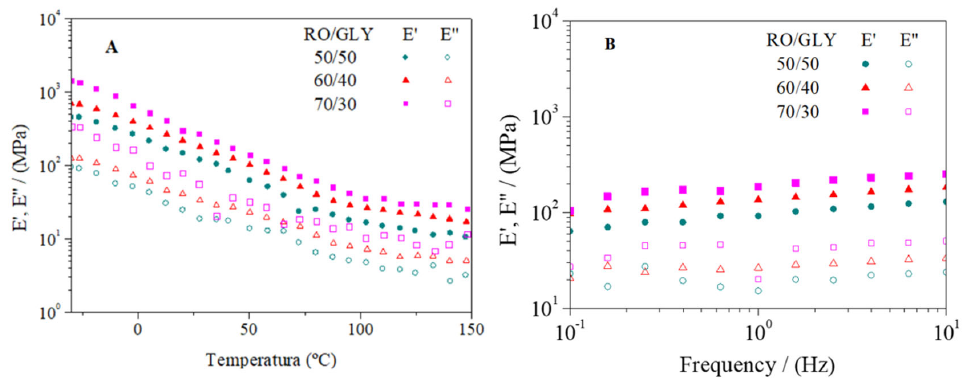
Figure 4. Evolution of viscoelastic moduli with temperature ( A ) and frequency ( B ) for bioplastics with different RO/GLY ratio (50/50, 60/40, 70/30).